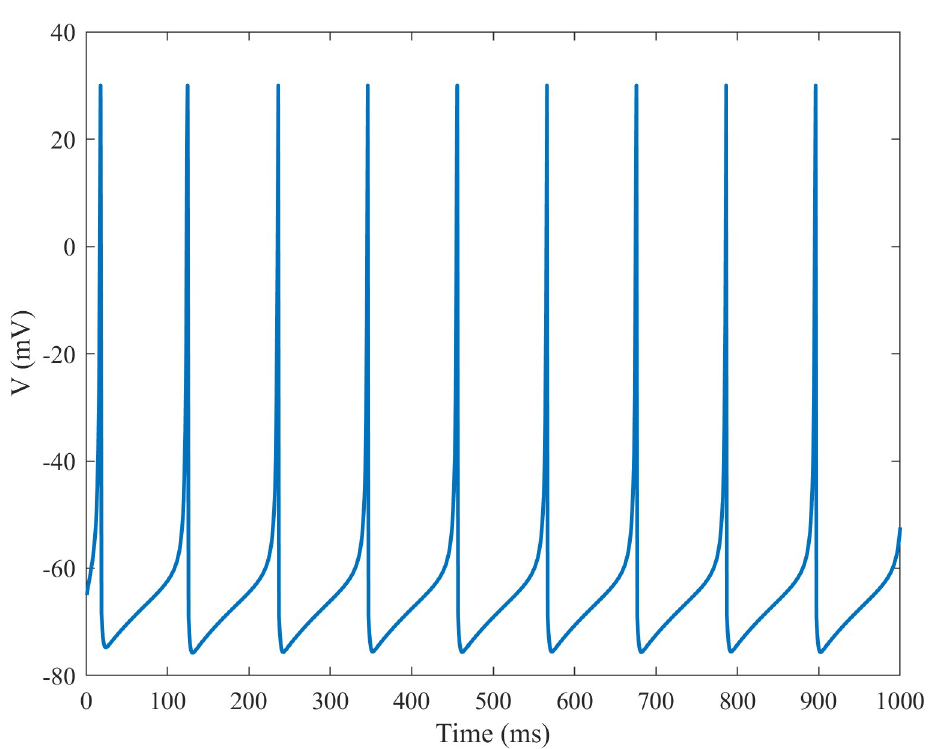
Fig 1. Firing patterns of the regular spiking mode of the Izhikevich neurons. The parameters of the excitatory neuron are: a = 0.02, b = 0.2, c = − 65, and d = 8.